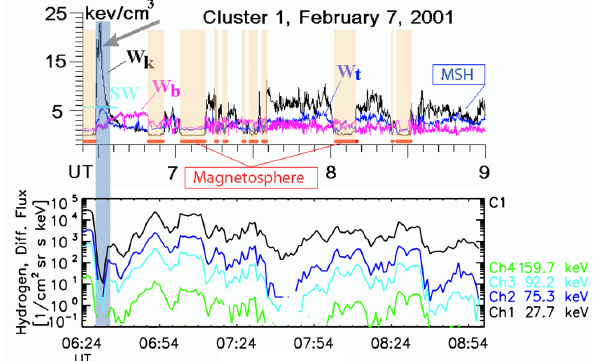
Fig. 3. 7 February 2001. Top panel: Cluster 1 ram W k (black), ion thermal W t (blue) and magnetic W b (violet) pressure; WIND ram pressure in SW during the first jet (outlined by gray arrow, see also Fig. 2) is shown by magenta horizontal line marked “SW”. Red thick lines above the horizontal axis and vertical pink shadings high- light the magnetosphere; the quiet MSH is indicated on the right by the framed “MSH”. Bottom panel: Proton intensities observed by Cluster 1, RAPID. The vertical blue transparent bar highlights the time period when the high-energy-density “super-jet” occurred si- multaneously with the proton intensity deepest